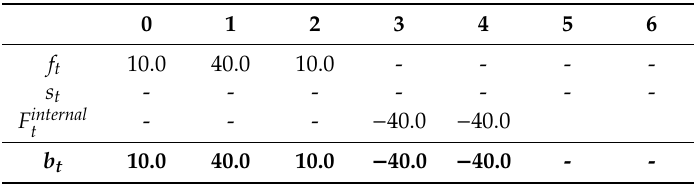
Table 2. Baseline calculation example for a battery.